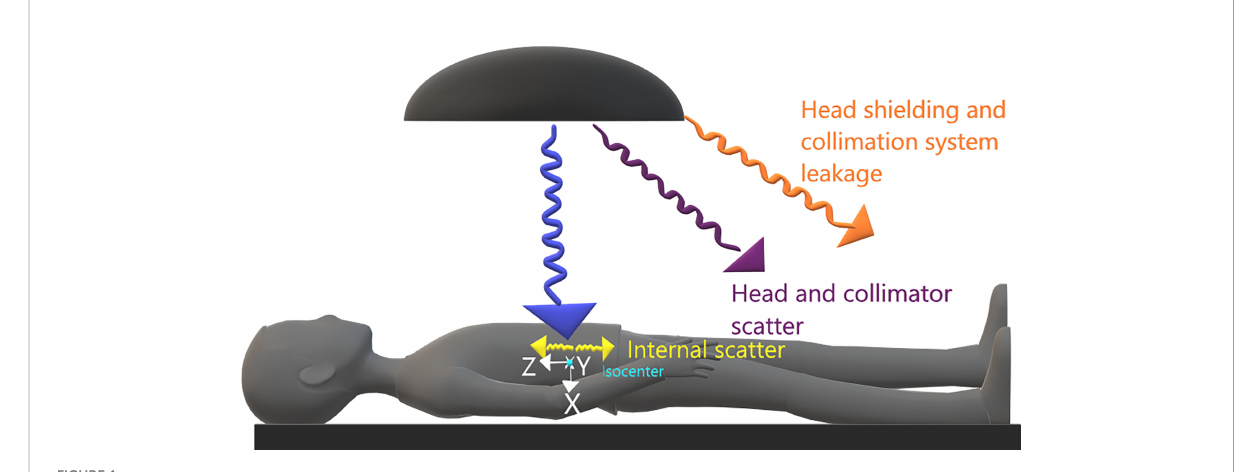
FIGURE 1 Representation of sources of peripheral dose and coordinate system at the present